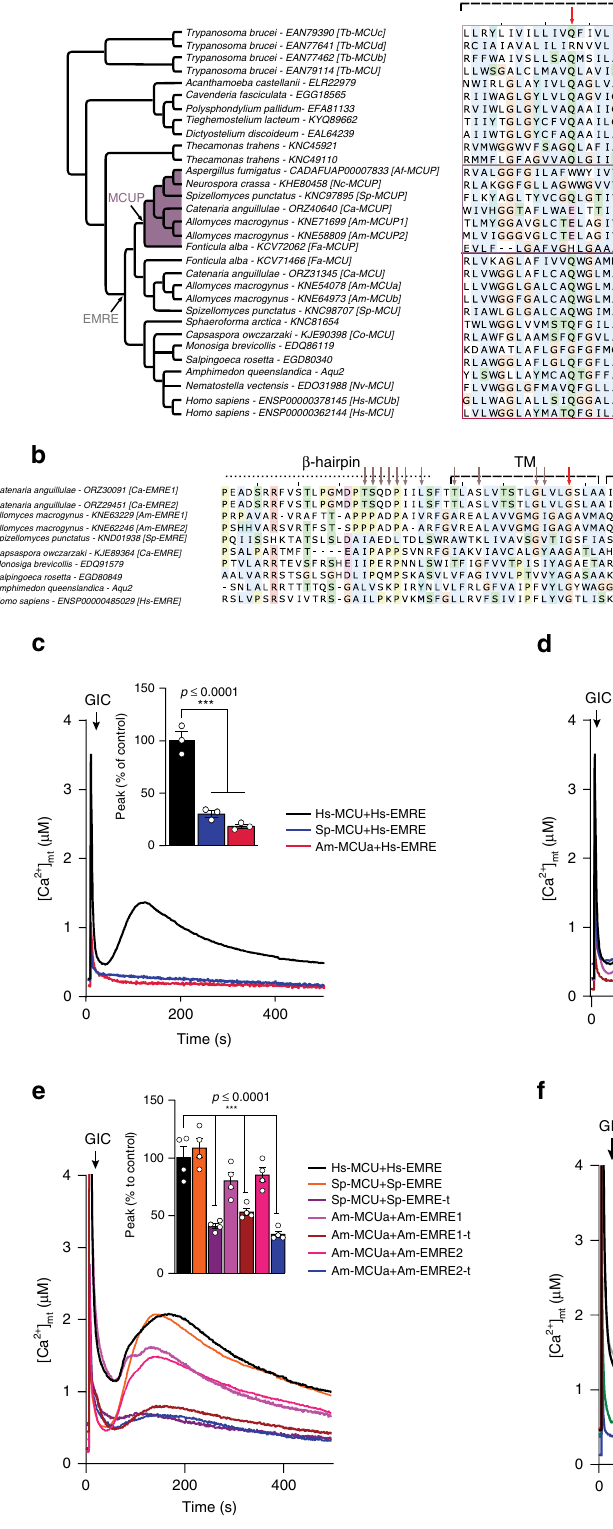
interactions. Our results show that human MCU can function in the presence of both human and chytrid EMREs, whereas chytrid MCUs such as Am-MCUa and Sp-MCU can only reconstitute mt-Ca 2 + uptake when co-expressed with their corresponding